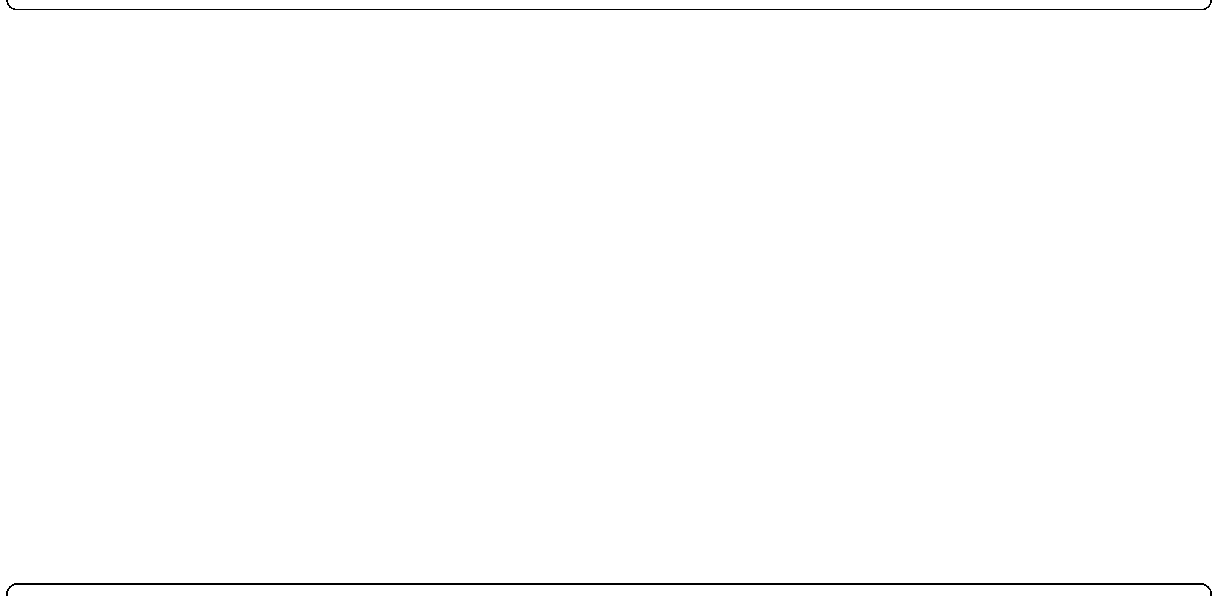
Fig. 13 A Case of poorly differentiated gastric adenocarcinoma. B Immunohistochemical staining of the tumor showing staining of tumor immune cells while tumor cells are predominantly negative. CPS: 20. (DAKO 22C3 antibody)